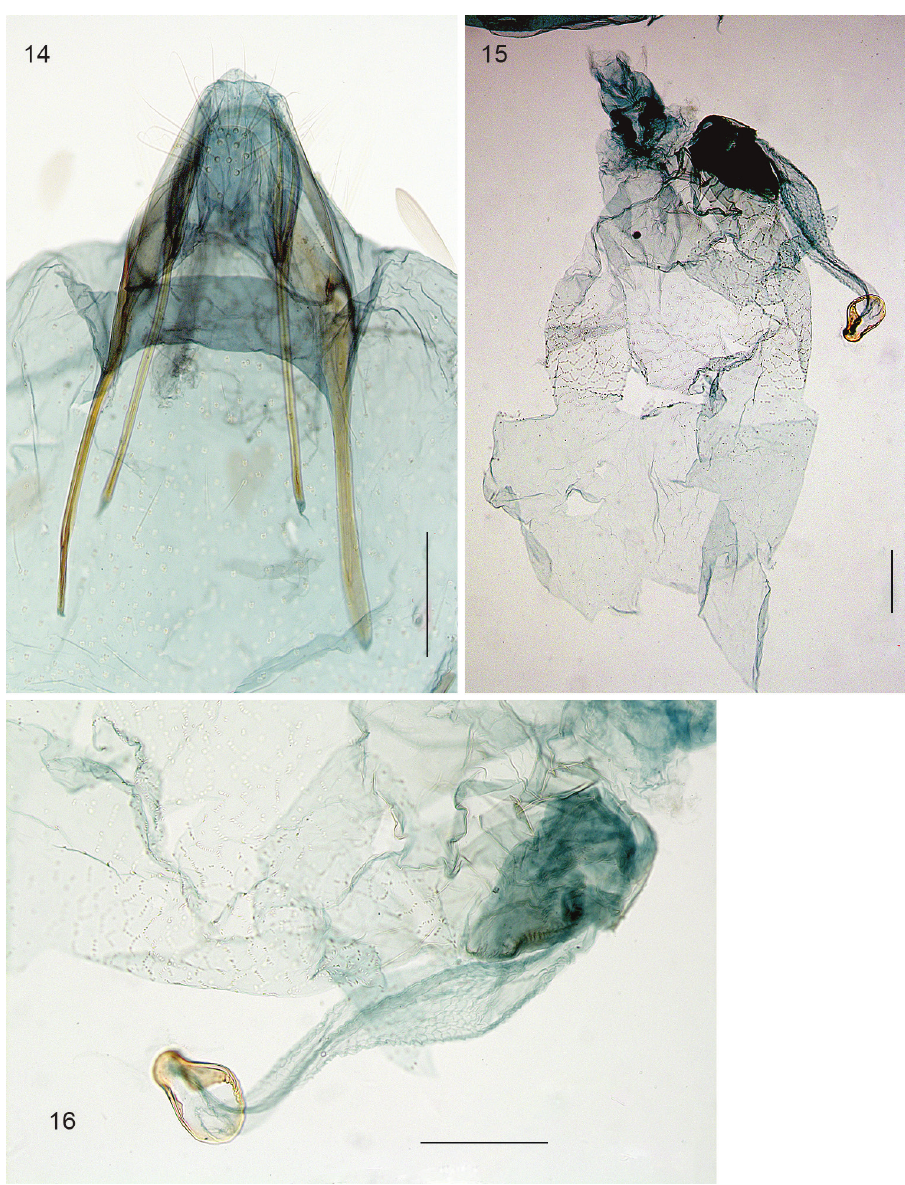
Figures 14–16. Stigmella gallicola , female genitalia, slide EvN3739. 14 Abdominal tip, focussed ventrally 15 Bursa, damaged 16 Detail of 15, with ductus spermathecae and vesicle. Scale bars: 100 µm. than 1 mm wide (Fig. 30). We found inquiline phorid fly larvae (Diptera: Phoridae) inhabiting old gall chambers. The gall was already recorded by Hanson et al. (2014). Egg . Egg position unknown. Probably laid near or at foliar nectaries (nectar glands) abaxially on primary veins of leaf buds or very young